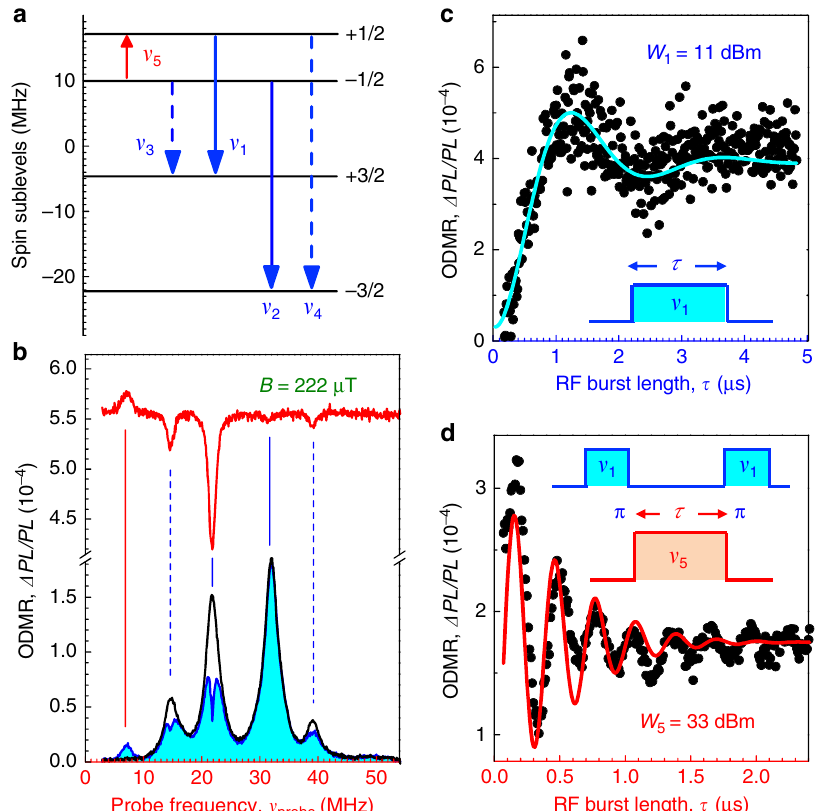
Fig. 3 Coherent manipulation of spin qudit modes. a MW-induced transitions between different spin sublevels after optical pumping into the m S = ±1/ 2 states. The solid and dashed arrows correspond to the transitions with large and small matrix elements, respectively. b ODMR spectra in a magnetic fi eld of 222 μ T with and without MW pump at v pump = 21.8 MHz. The upper curve shows the spectrum of the excited qudit modes. c Rabi oscillations at the v 1 resonance driven by the MW power W 1 = 11 dBm with the corresponding π -pulse duration of 1.2 μ s. d Rabi oscillations of a spin packet at the v 5 resonance driven by the MW power W 5 = 33